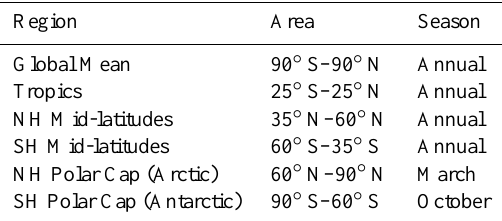
Table 2. Geographical regions considered in the analysis. Region